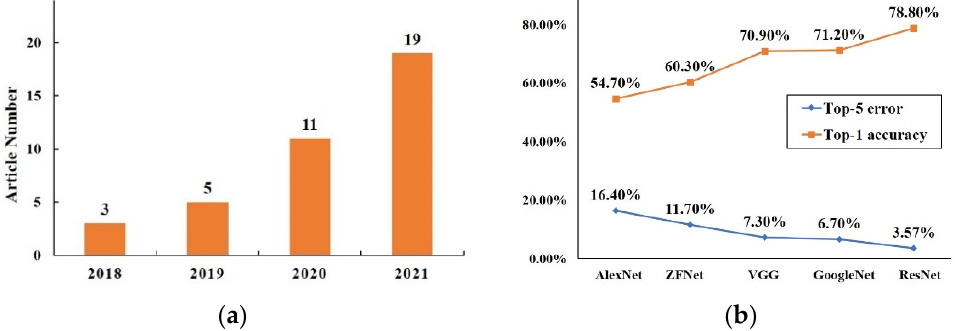
Figure 1. ( a ) Deep learning in DAS from 2018 to 2021; ( b ) performance comparison of different CNN architectures based on ImageNet data set